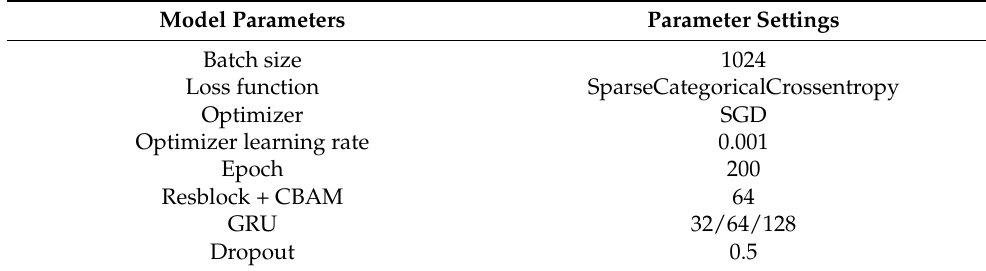
Table 2. Model parameter settings.